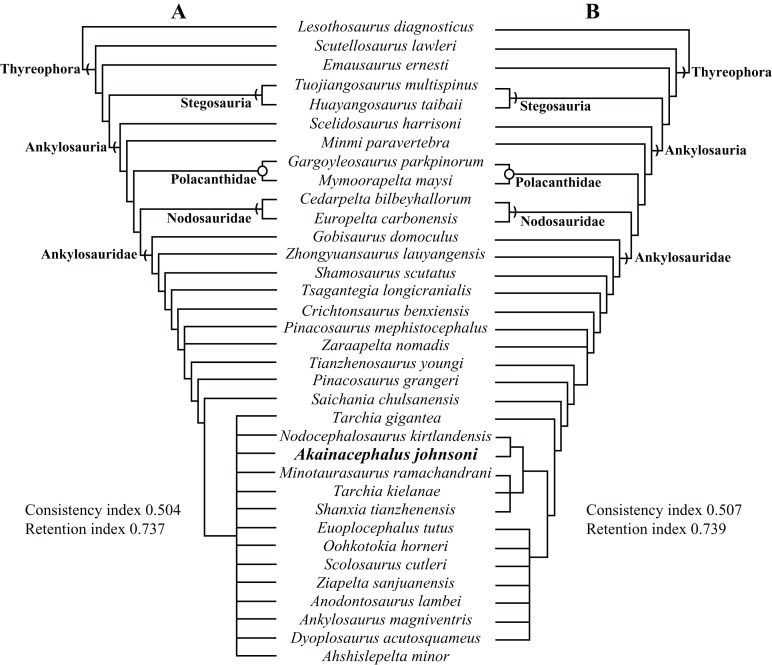
Results of phylogenetic analyses for Akainacephalus johnsoni.Phylogenetic position of Akainacephalus johnsoni in (A), a strict consensus of 21 equally most parsimonious trees, including the wildcard taxon Ahshislepelta minor, placing A. johnsoni within a large polytomy, consisting of crown group taxa that include Asian and all Laramidian ankylosaurids; and (B), the resulting strict consensus of six equally most phylogenetic trees, from which the wildcard taxon Ahshislepelta minor has been pruned. The crown group taxa are slightly better resolved in the pruned analysis, in which Akainacephalus johnsoni forms a clade with its sister taxon Nodocephalosaurus kirtlandensis, nested within the clade that also includes the Asian taxa Minotaurasaurus ramachandrani, Tarchia kilanae, and Shanxia tianzhenensis, suggesting a close taxonomic relationship with Nodocephalosaurus kirtlandensis and Asian taxa.